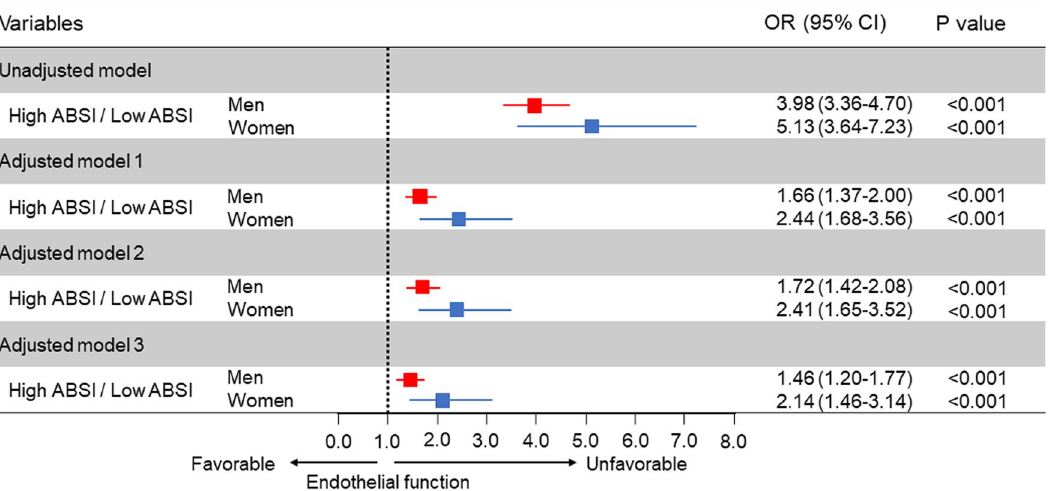
Figure 6. Odds ratios and 95% confidence intervals for predicting patients with a history of cardiovascular disease of high a body shape index (ABSI) using the low ABSI group as the reference. Low ABSI indicates less than 0.0796 in men and less than 0.0823 in women. Model 1: Adjusted for age. Model 2: Adjusted for age, body mass index, and smokers. Model 3: Adjusted for age, body mass index, presence of hypertension, dyslipidemia, and diabetes, and